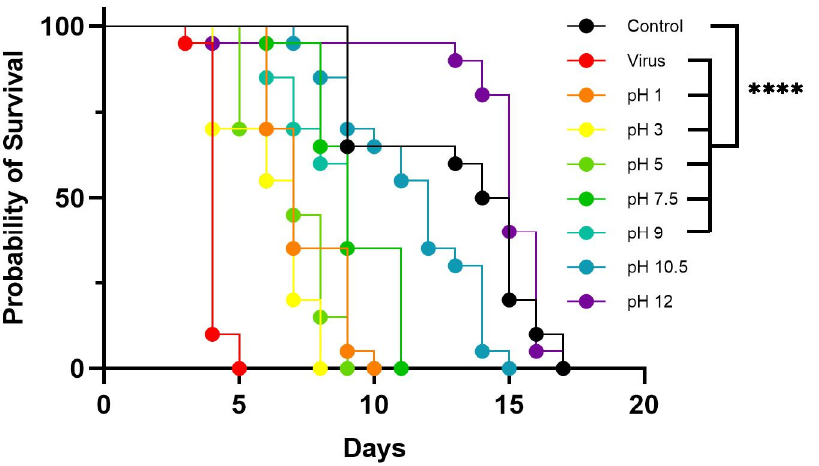
Figure 5. Survival of flies after exposure to LJV pre-treated in buffers over a broad pH range. Black = untreated negative control, red = LJV ‐ fed positive control without pretreatment. LJV high concen ‐ tration (HC, 10 6 GE/mL) was used. Other lines represent LJV ‐ fed flies following different pH treat ‐ ments, as shown in the color key. Statistical analysis (Kaplan–Meier) indicated a significant differ ‐ ence (**** p < 0.0001) between the negative control and flies exposed to LJV following all pre ‐ treat ‐ ments except pH 10 and 12.5.